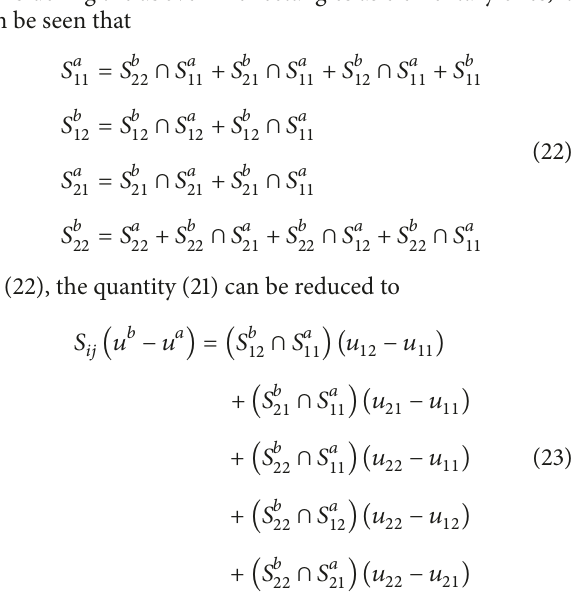
Table 3: An Example of an LRB